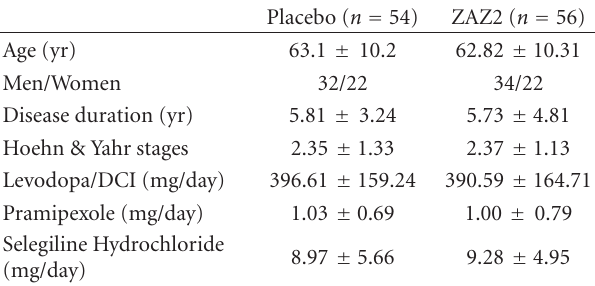
Table 1: Patient